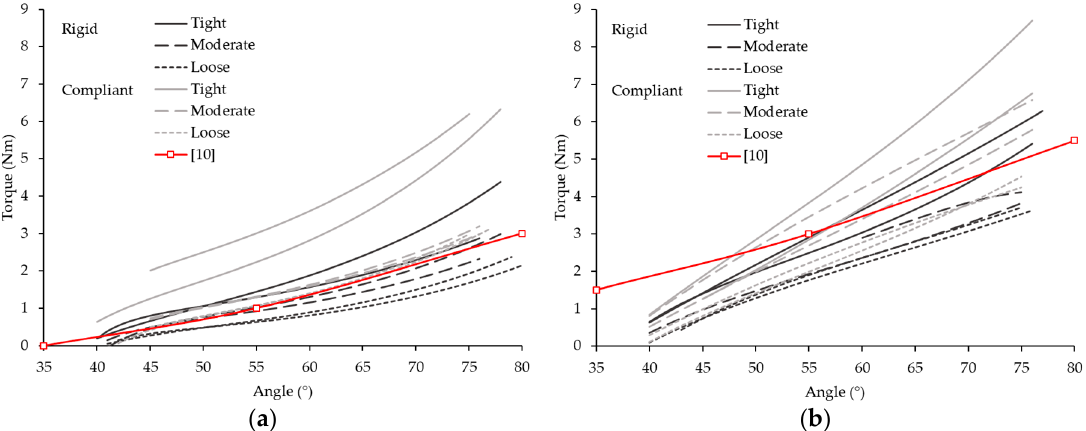
Figure 4. Torque vs. angle for test 1 of a new and used protector at each strapping condition (tight— solid line, moderate—broken line, loose—dotted line), for ( a ) short and ( b ) long protector, plotted alongside data (digitised from graph) from